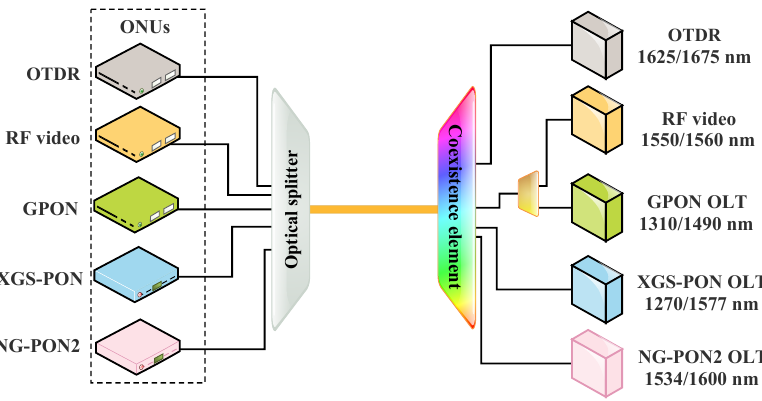
Figure 25. PON system coexistence (adapted from the work in